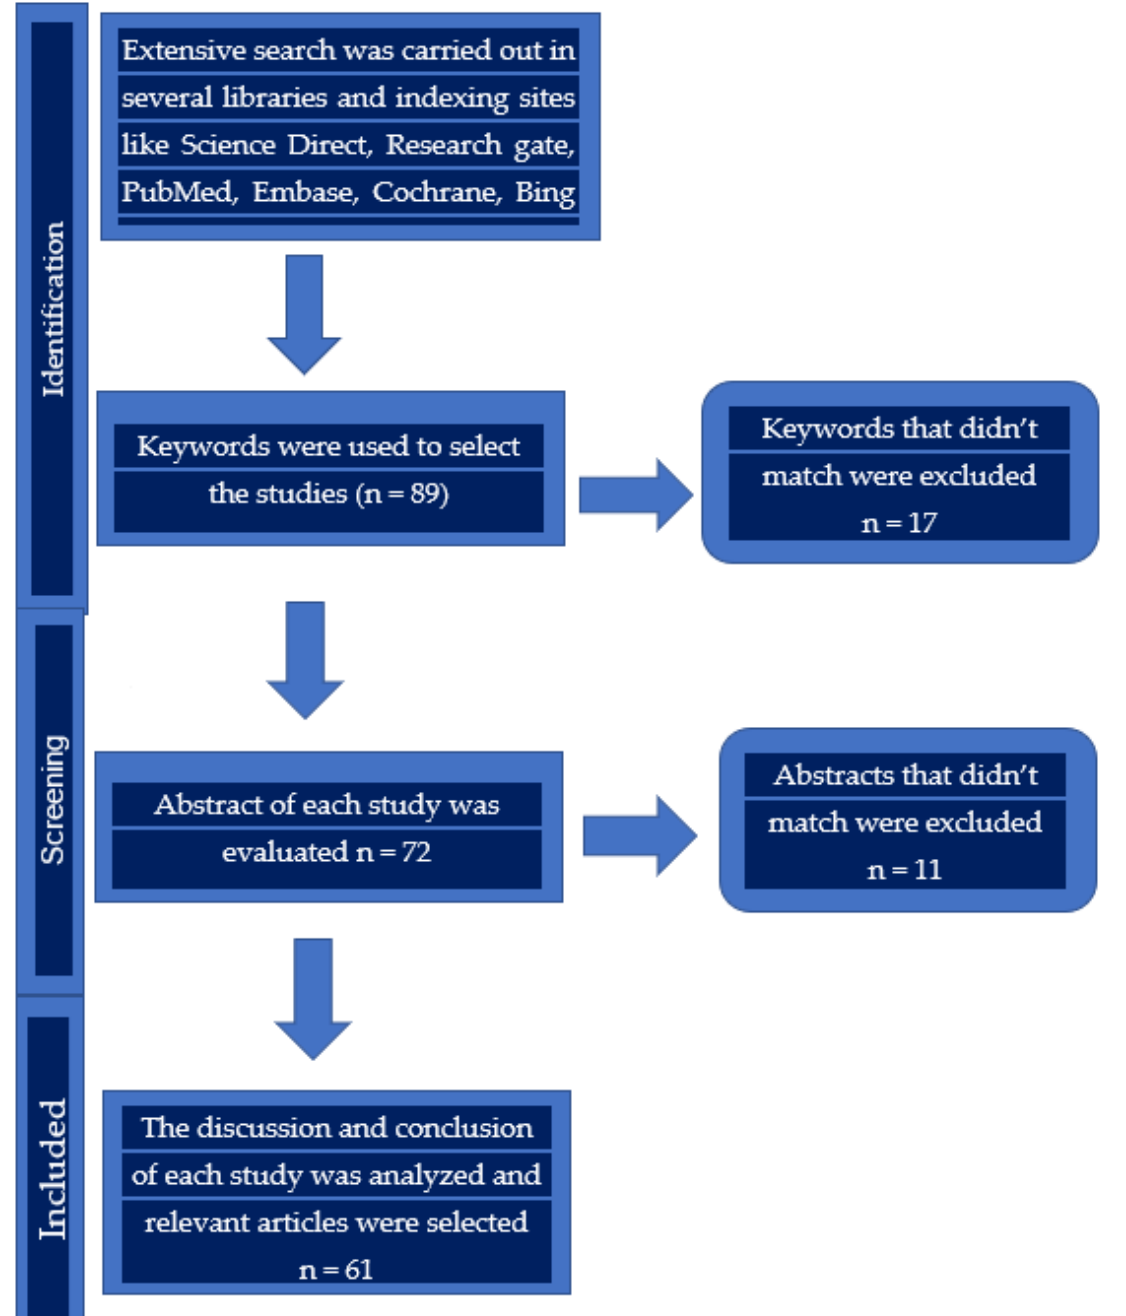
Figure 1. The flow chart of article selection process for this review.